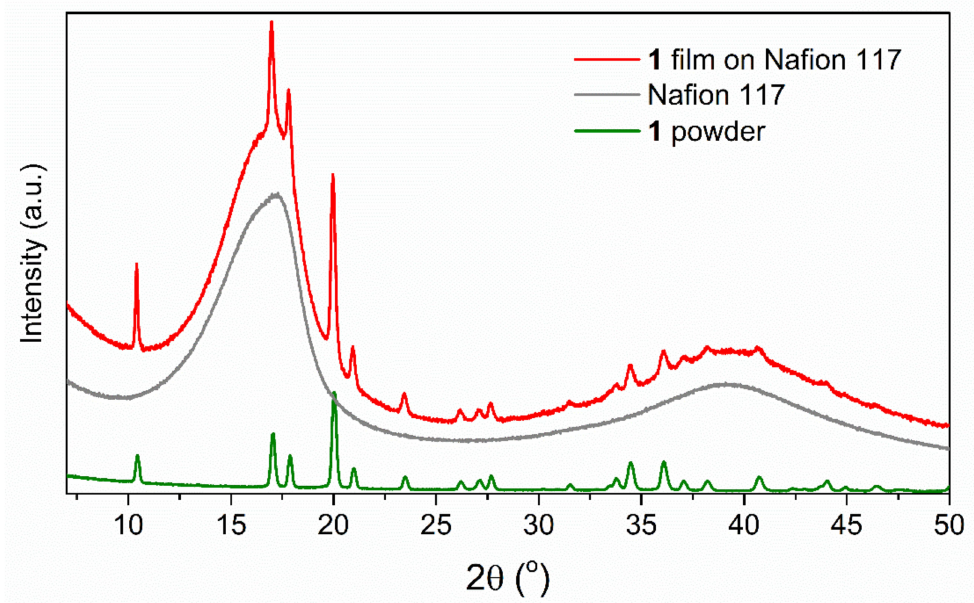
Figure 2. The XRD pattern measured for the Nafion ® 117 membrane, {[Fe II (H 2 O) 2 ] 2 [Nb IV (CN) 8 ] ·